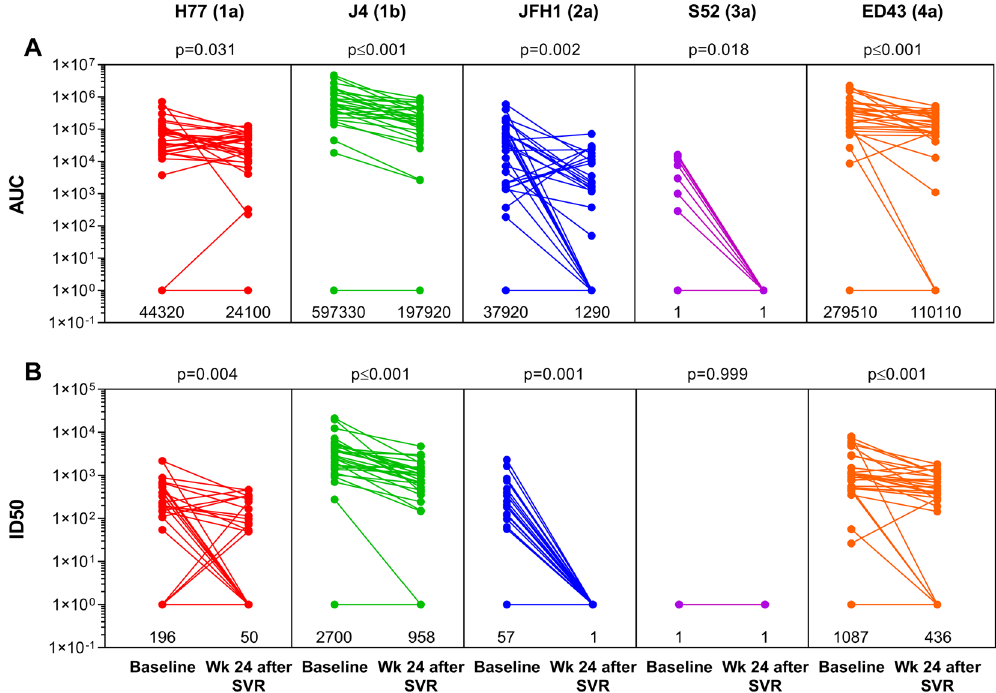
Figure 2. Impact of HCV clearance on HCV-nAb titers in HIV/HCV-coinfected patients who achieved sustained virological response. Abbreviations: AUC, area under the curve (arbitrary units); ID50, 50% inhibitory dose; SVR, sustained virological response; Wk, week. Statistics: p-values were calculated by the Wilcoxon test. Median values of AUC and ID50 are shown under each aligned dot plot.